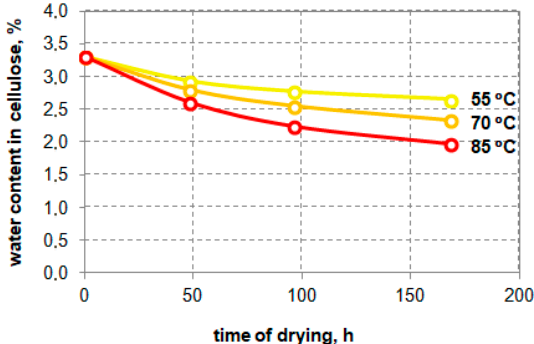
the moisture content of cellulose for various temperatures; prepared on the basis of data from [2].